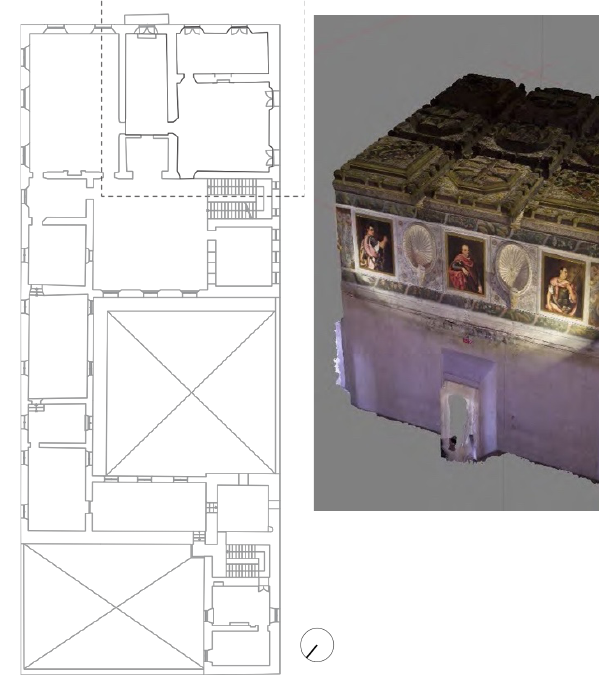
Figure 2. First floor of Palazzo Ducale with surveyed rooms and Photoscan screenshot of the Sala degli Imperatori